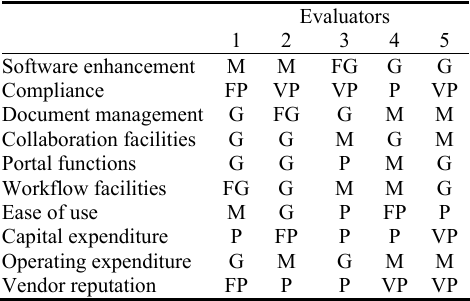
Table 6. The linguistic evaluation of alternative